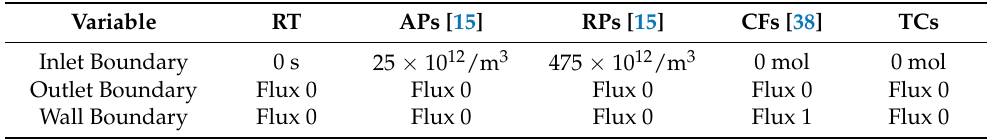
Table 2. The boundary conditions of the reaction